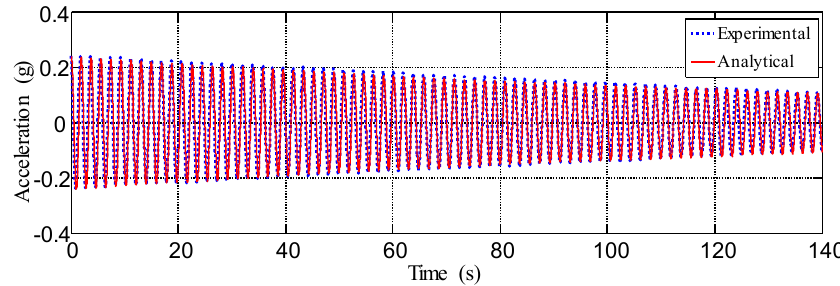
Figure 8. Free vibration signal for system identification of the bridge model.